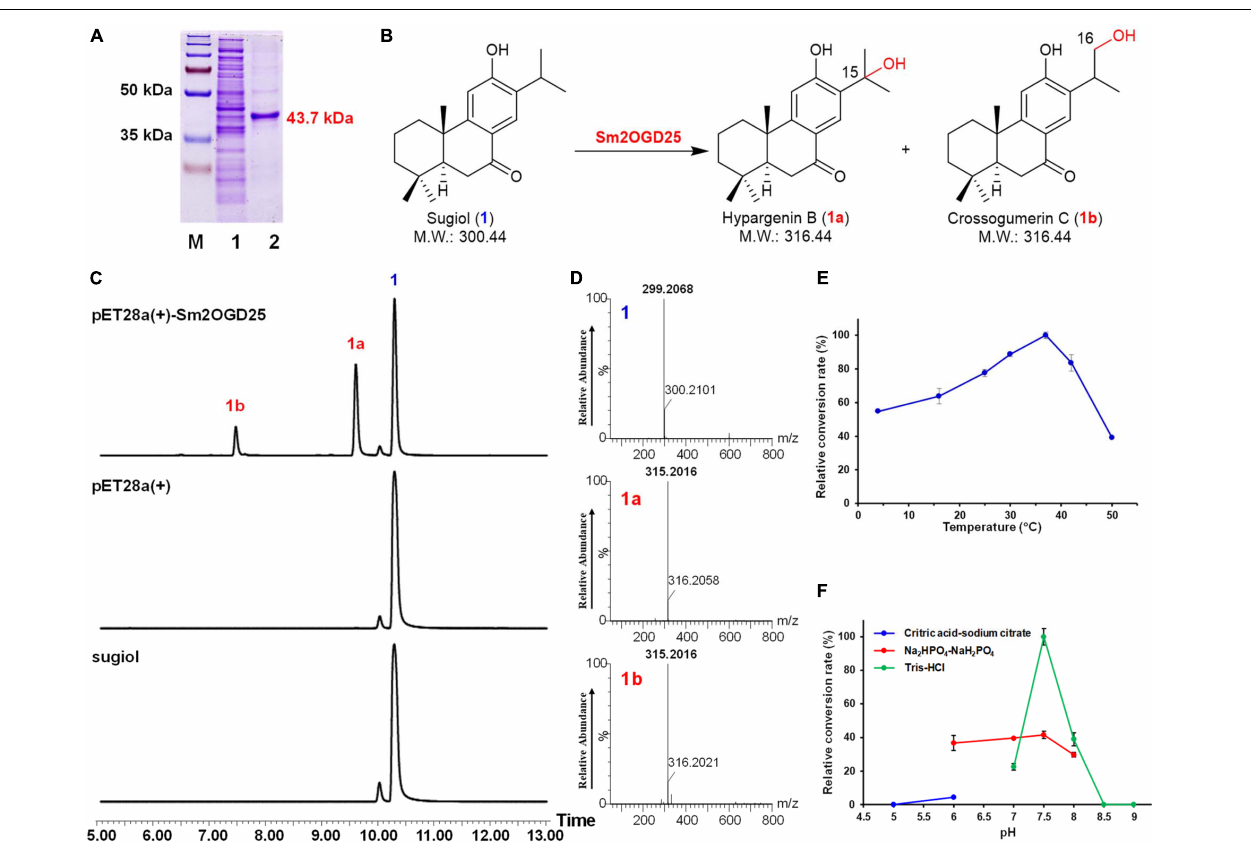
FIGURE 3 | Functional characterization of recombinant Sm2OGD25. (A) SDS-PAGE of the His-tagged Sm2OGD25 purified by Ni-NTA affinity chromatography. M: protein marker; 1: crude protein of Sm2OGD25; 2: recombinant Sm2OGD25 (purity > 95%) fused with His-tag (predicted M.W.: 43.7 kDa). (B) Enzymatic reaction catalyzed by Sm2OGD25. (C) UPLC-QTOF-MS analysis of 1 and enzymatic product 1a and 1b. (D) (-)-ESI-MS spectra of 1, 1a, and 1b in the negative ion mode. The analysis conditions are described in Supplementary Table 2 . Effects of temperature (E) and reaction buffer (F) on enzyme activity of Sm2OGD25.